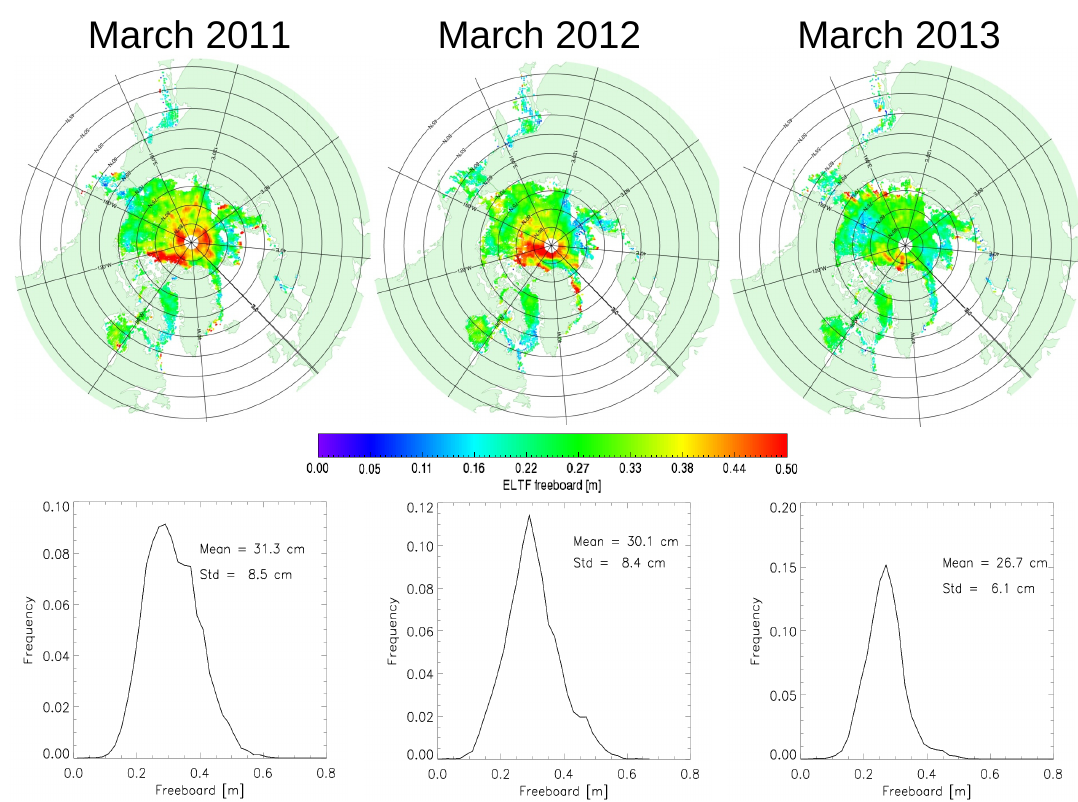
Figure 11. Maps of the monthly mean gridded sea ice freeboard, f b radar , and their probability distributions from CryoSat-2 from the ELTF method.